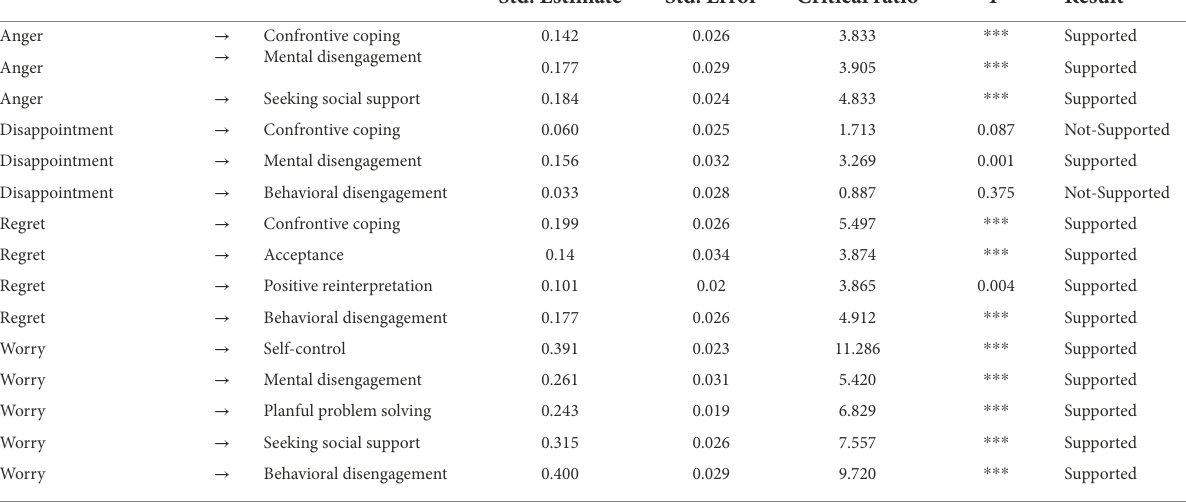
TABLE 5 Structural model.